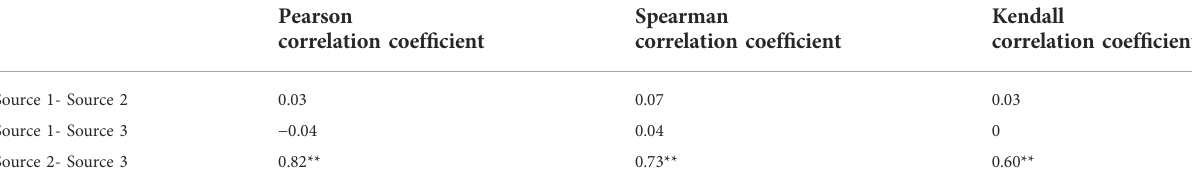
TABLE 1 The results of runoff correlation measurements for multiple water sources by various correlation coef fi